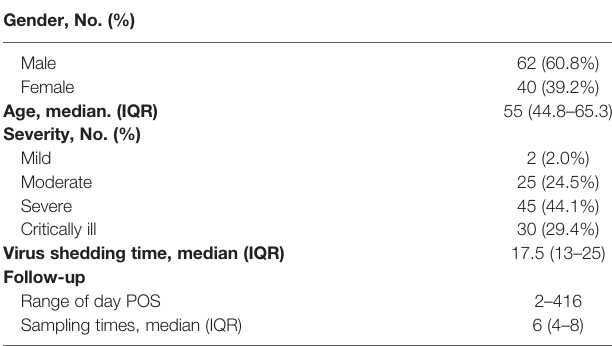
TABLE 1 | Demographic characteristics of patients infected with SARS-CoV-2. Gender, No.